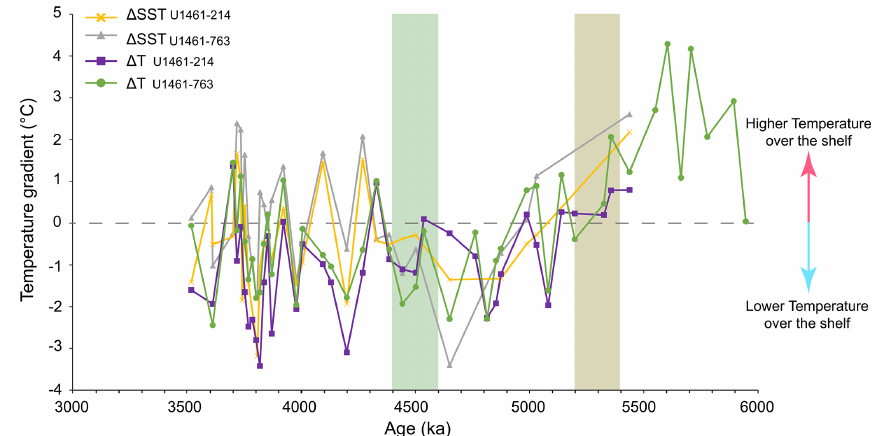
Figure 6. Temperature gradients ( (cid:49) SST and (cid:49)T ) between IODP Site U1461 (NW Australian shelf), ODP Site 763 (Exmouth Plateau), and DSDP Site 214 (eastern Indian Ocean). Gradients are calculated between the U k Mg / Ca records ( (cid:49)T ) for the interval 6–3.5Ma. The horizontal dashed grey line indicates no difference in temperature ( (cid:49) SST, (cid:49)T = 0 ◦ C). Brown shading corresponds to the stepwise decrease in NSI and the stepwise increase in NAR of bloom-forming species. The green shading represents the interval of the significant decrease in PP and NAR of bloom-forming